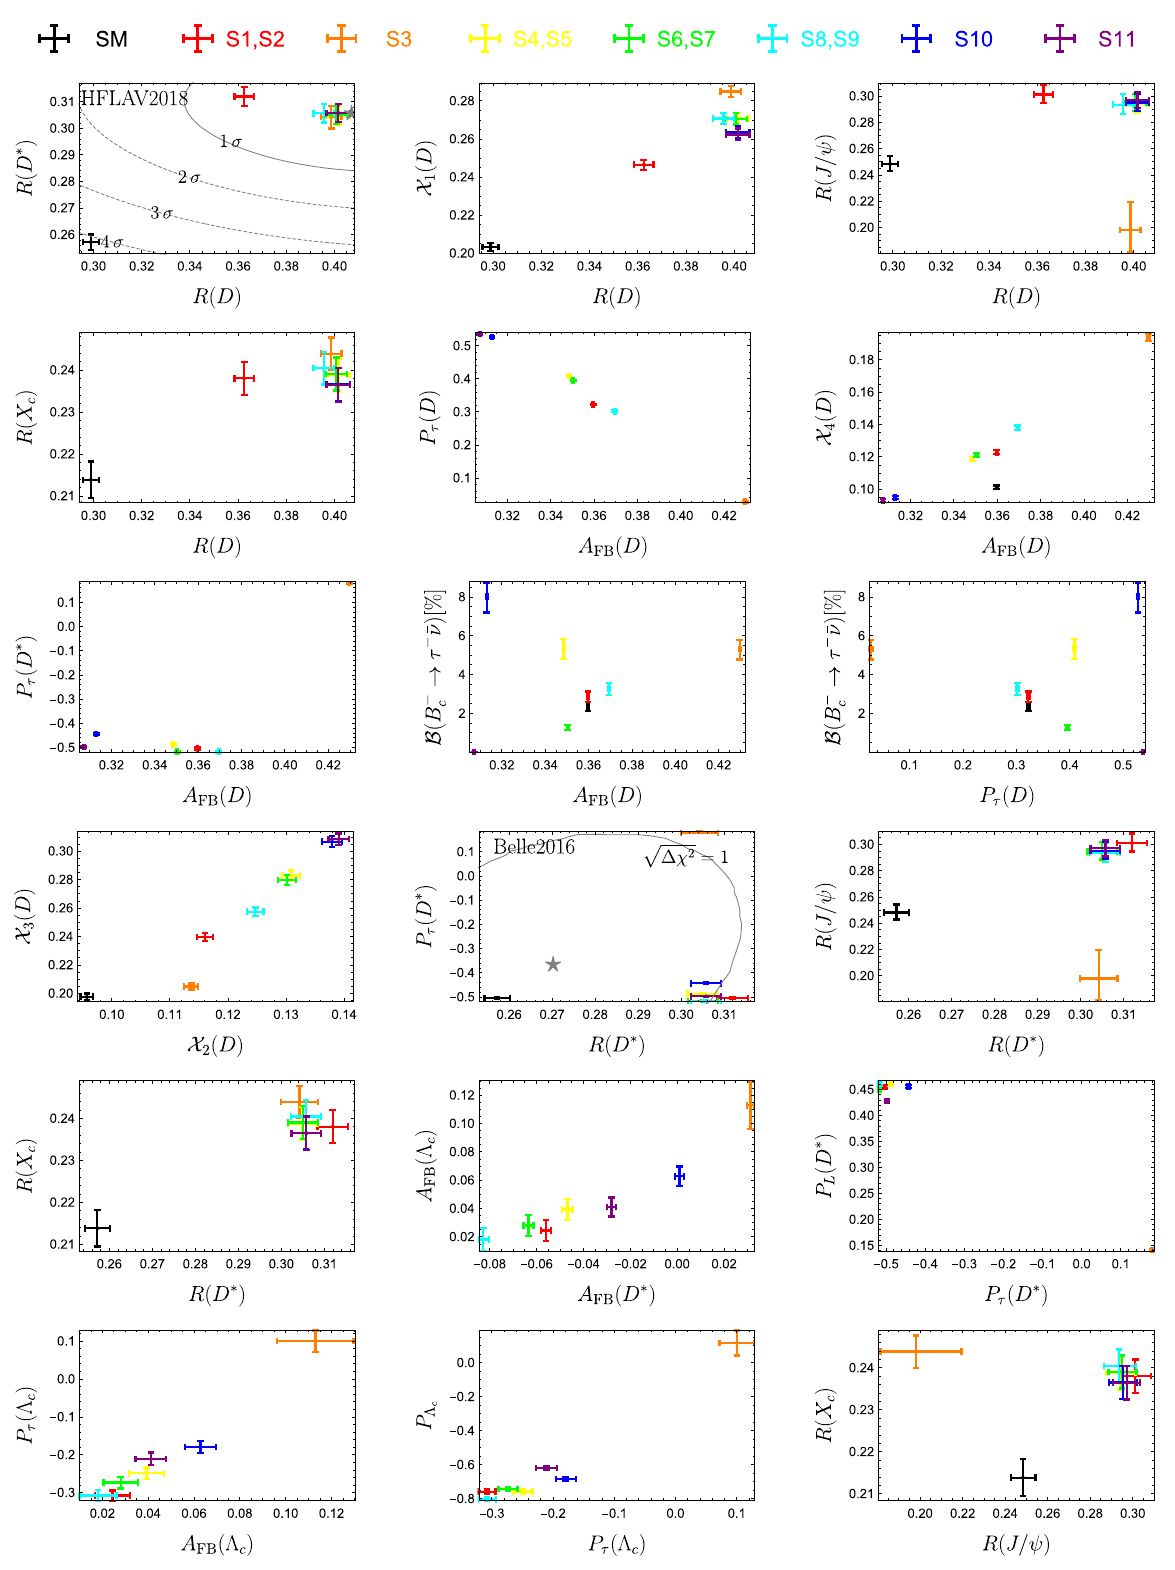
Fig. 3 Correlations among some of the observables discussed in this paper. Gray star point in the R ( D ) − R ( D ∗ ) and R ( D ∗ ) − P τ ( D ∗ ) plots correspond to the experimental central